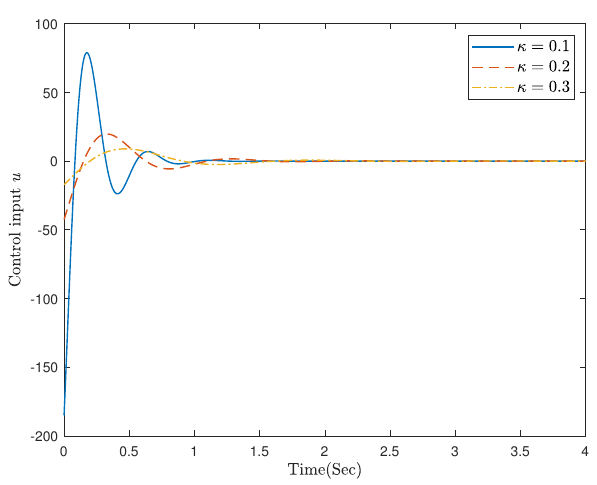
Figure 4. The trajectories of system state x 2 .